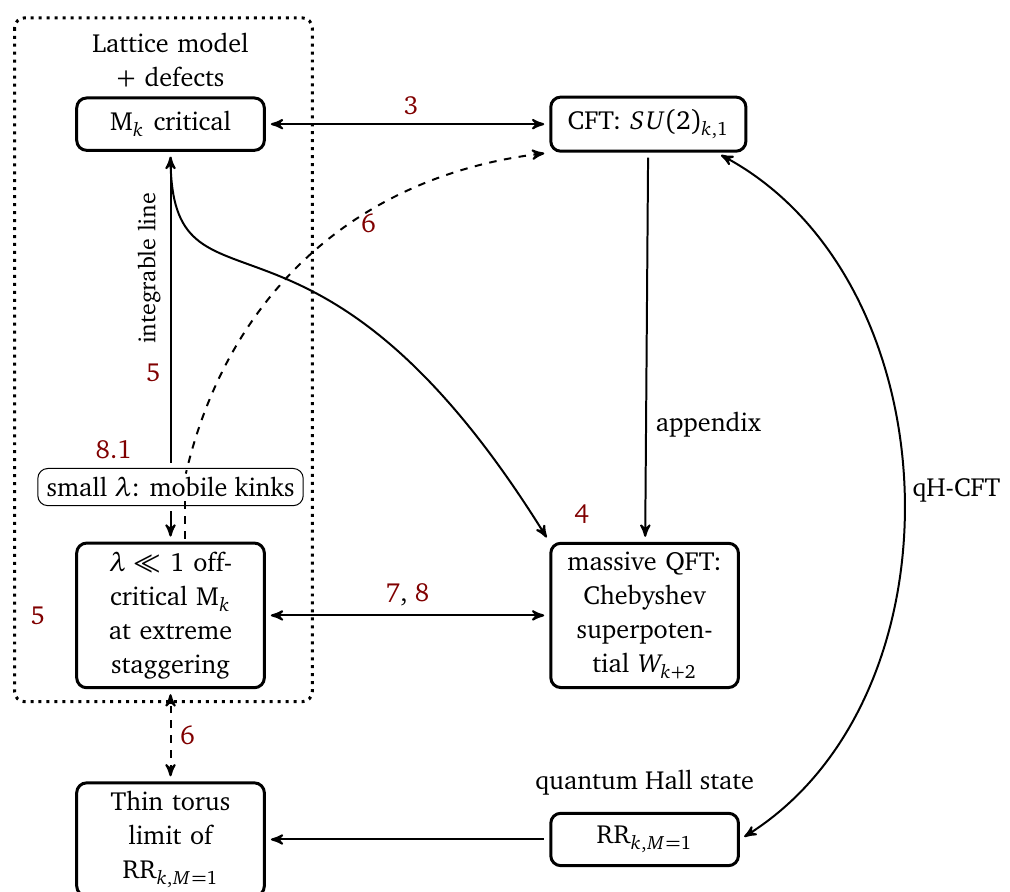
Figure 1: Overview of the connections studied in this paper. The numerals going with the ar- rows indicate the section where the relation is discussed. Some of the important connections are as follows. (i) The critical M model is related to the k -th superconformal (cid:78) = 2 minimal k model, here denoted as SU ( 2 ) (section 3). (ii) The massive QFT with Chebyshev superpo- k ,1 tentials arises from the weakly staggered lattice model through RG flow, or alternatively from a relevant perturbation of the CFT (section 4, appendix). (iii) The off-critical lattice model can be studied in the extreme staggering limit λ (cid:28) 1 and, close to this limit, in perturbation theory in λ (section 5). A direct relation between the extreme staggering limit and the CFT can be made by counting the kinks in this limit and relating the counting formulas to characters in the CFT (section 6). (iv) The k -th minimal CFT is via the quantum Hall-CFT correspondence related to the Read-Rezayi quantum Hall state with order- k clustering, here denoted as RR k (section 6). (v) The lattice model kinks at extreme staggering are in many ways similar to the fundamental kinks in the massive QFT - we compare the two in sections 7,